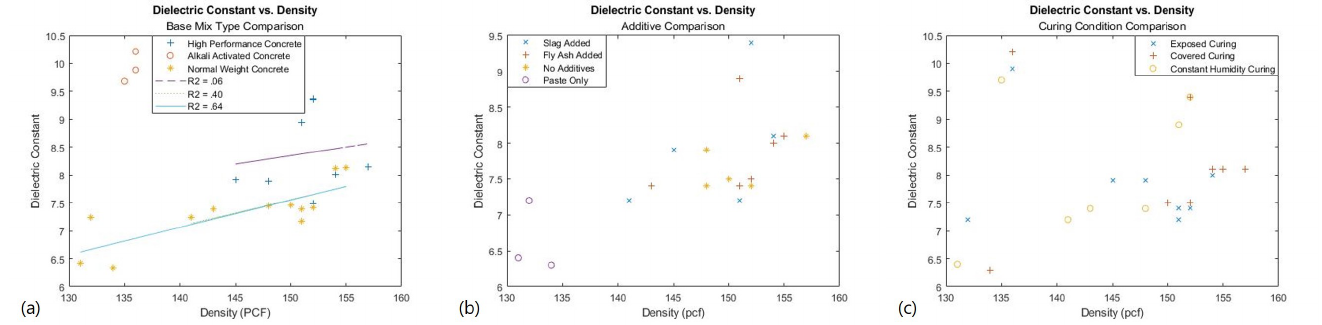
Figure 8. Dielectric constant vs. density (pounds per cubic foot, pcf) with breakdowns of base mix